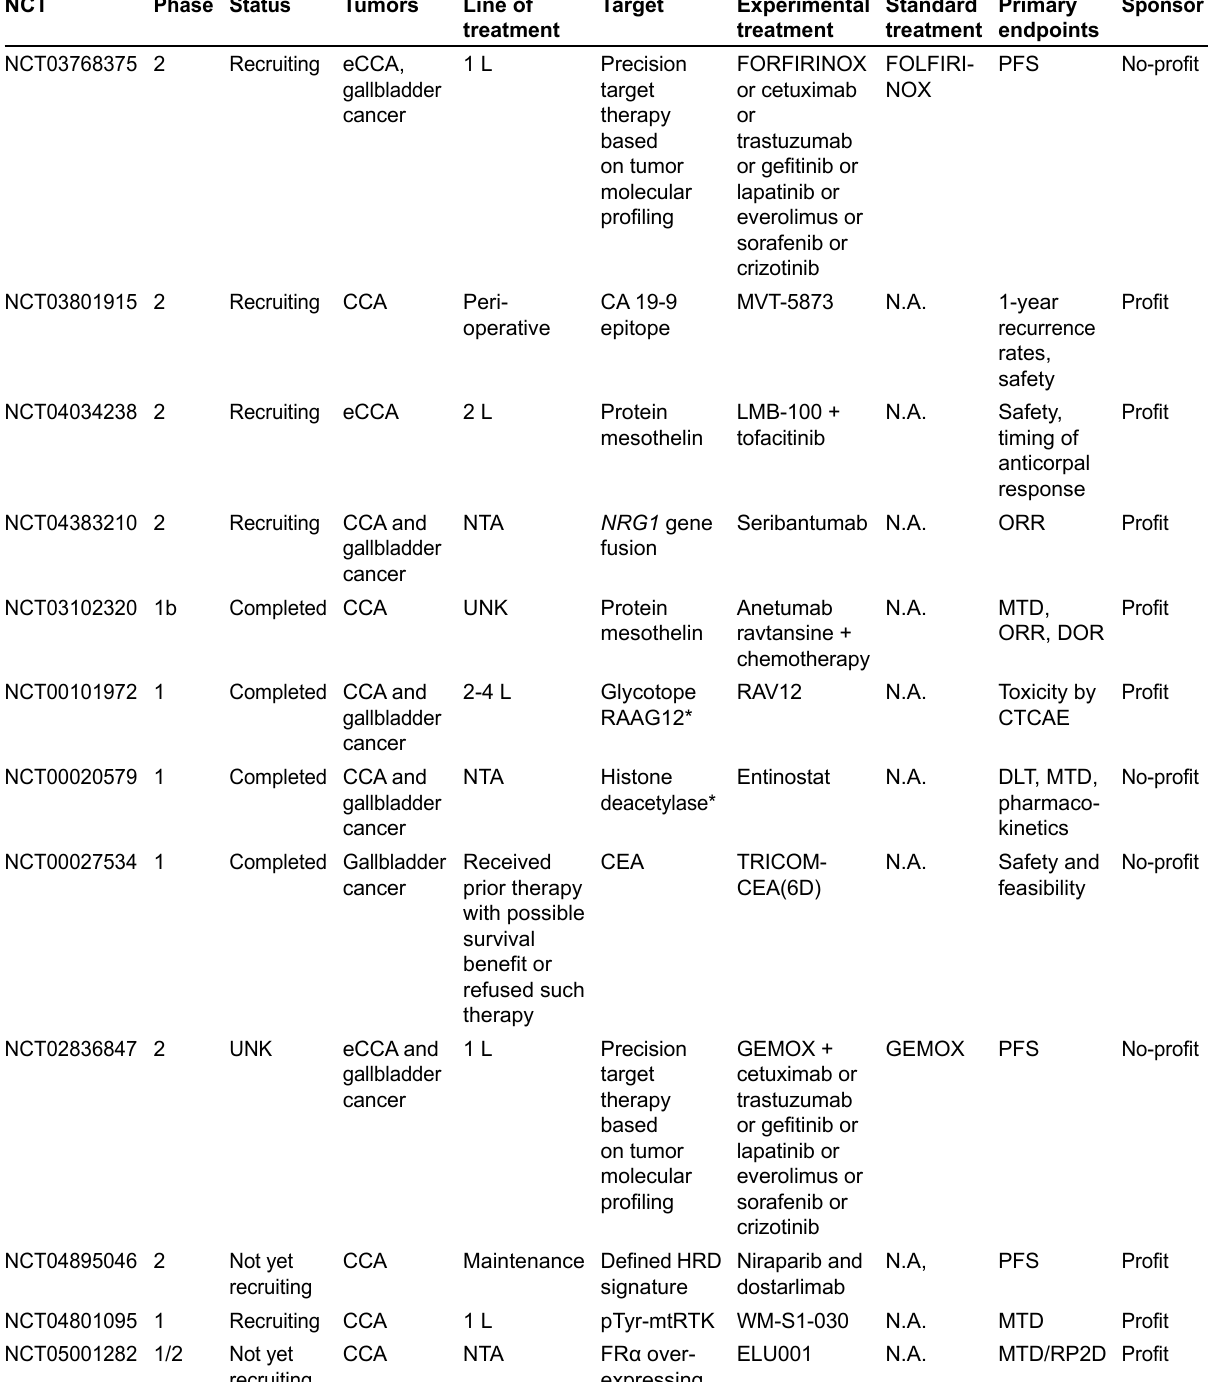
Table 5. Active trials, both recruiting and not recruiting, testing targets not aforementioned (IDH, FGFR, PARP, HER2, ALK, ROS, and the MAPK pathway) ( continued